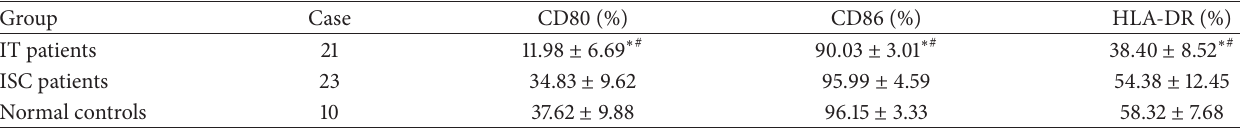
Figure 1: Morphological characteristics of dendritic cells in light microscope that were cultured for 7 days from two kinds of chronic HBV carriers and healthy controls × 200. (a) Dendritic cells cultured from patients in immune tolerance; (b) dendritic cells cultured from patients in inactive HBsAg carrier state; (c) dendritic cells cultured from normal controls. Table 2: Detection of dendritic cells’ phenotypes in patients and normal controls (%, mean ±